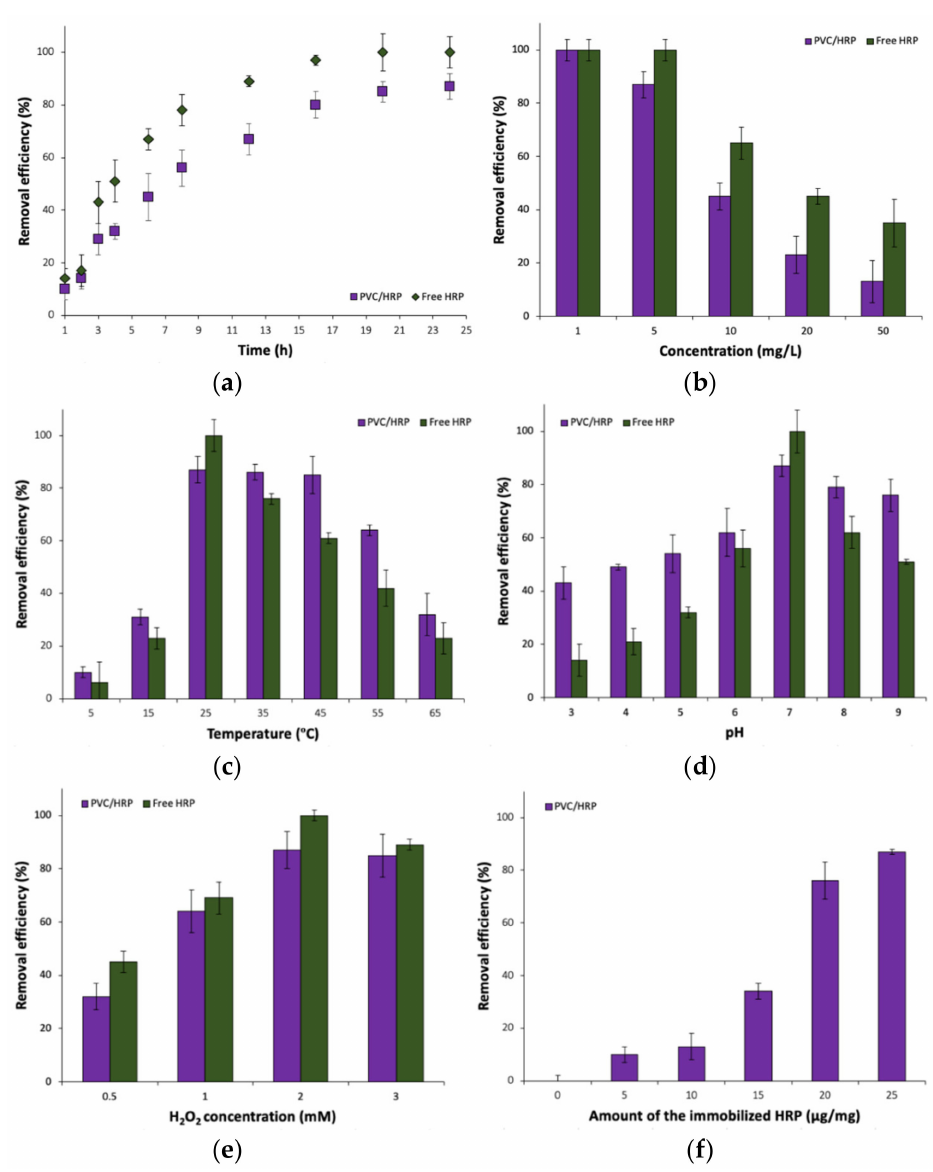
Figure 3. The effect of: ( a ) time process; ( b ) concentration of SMX; ( c ) temperature; ( d ) pH; ( e ) H 2 O 2 concentration and ( f ) amount of the immobilized HRP on SMX removal